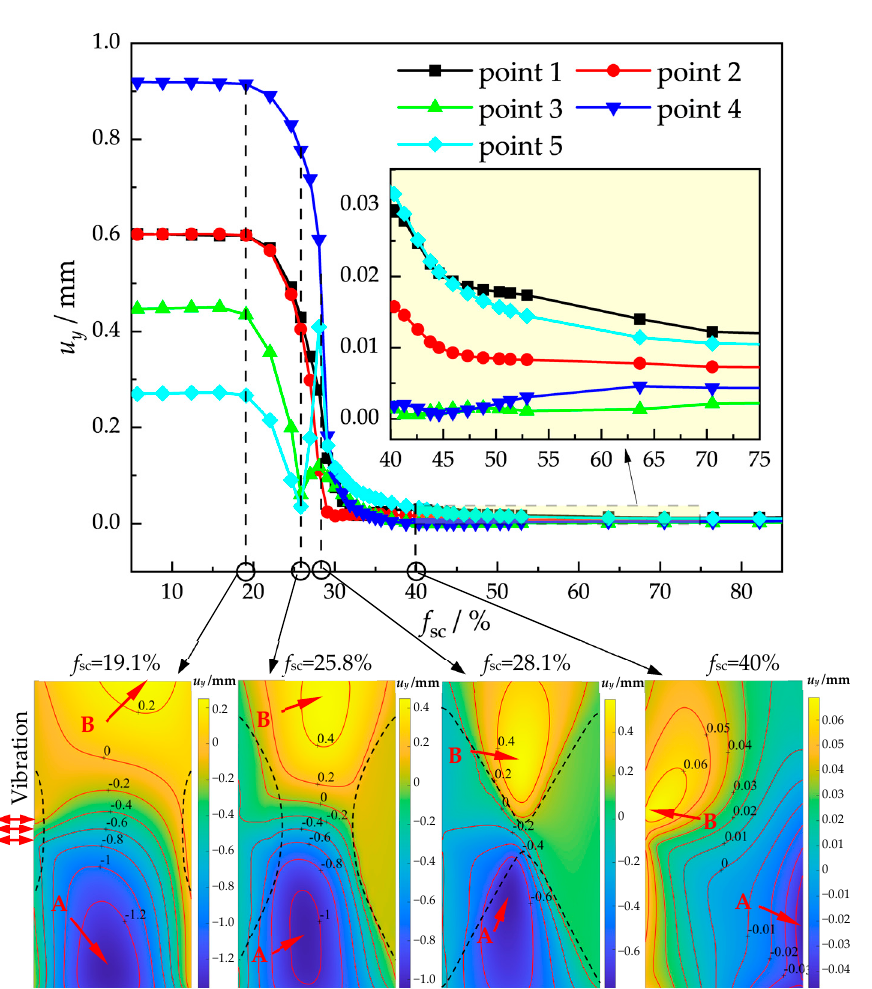
Figure 11. Variation in the displacement amplitude of u y with the solid fraction of the feeding channel 𝑓 sc . Note: Letters A, B and red arrows indicate the extreme u y .